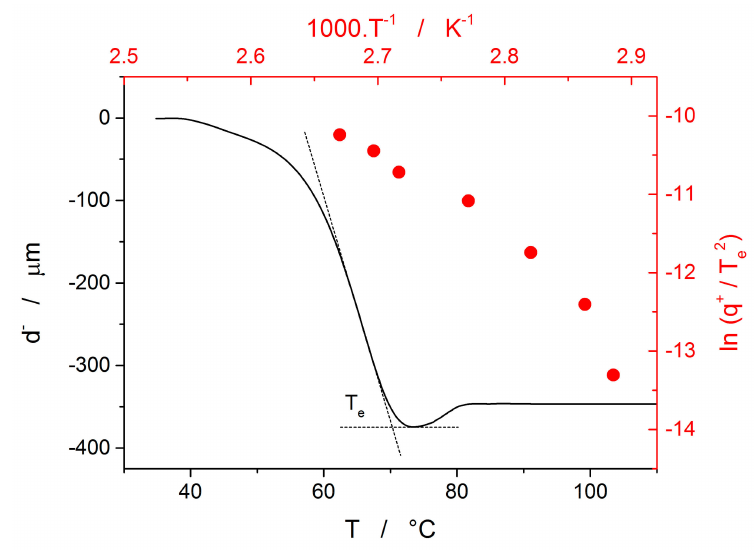
Figure 9. Black-based data and axes show an example thermomechanical analysis (TMA) crystallization curve (obtained at 0.2 ◦ C · min − 1 ); evaluation of the extrapolated endset is illustrated. Red-based data and axes show the Kissinger plot for the TMA crystallization data.